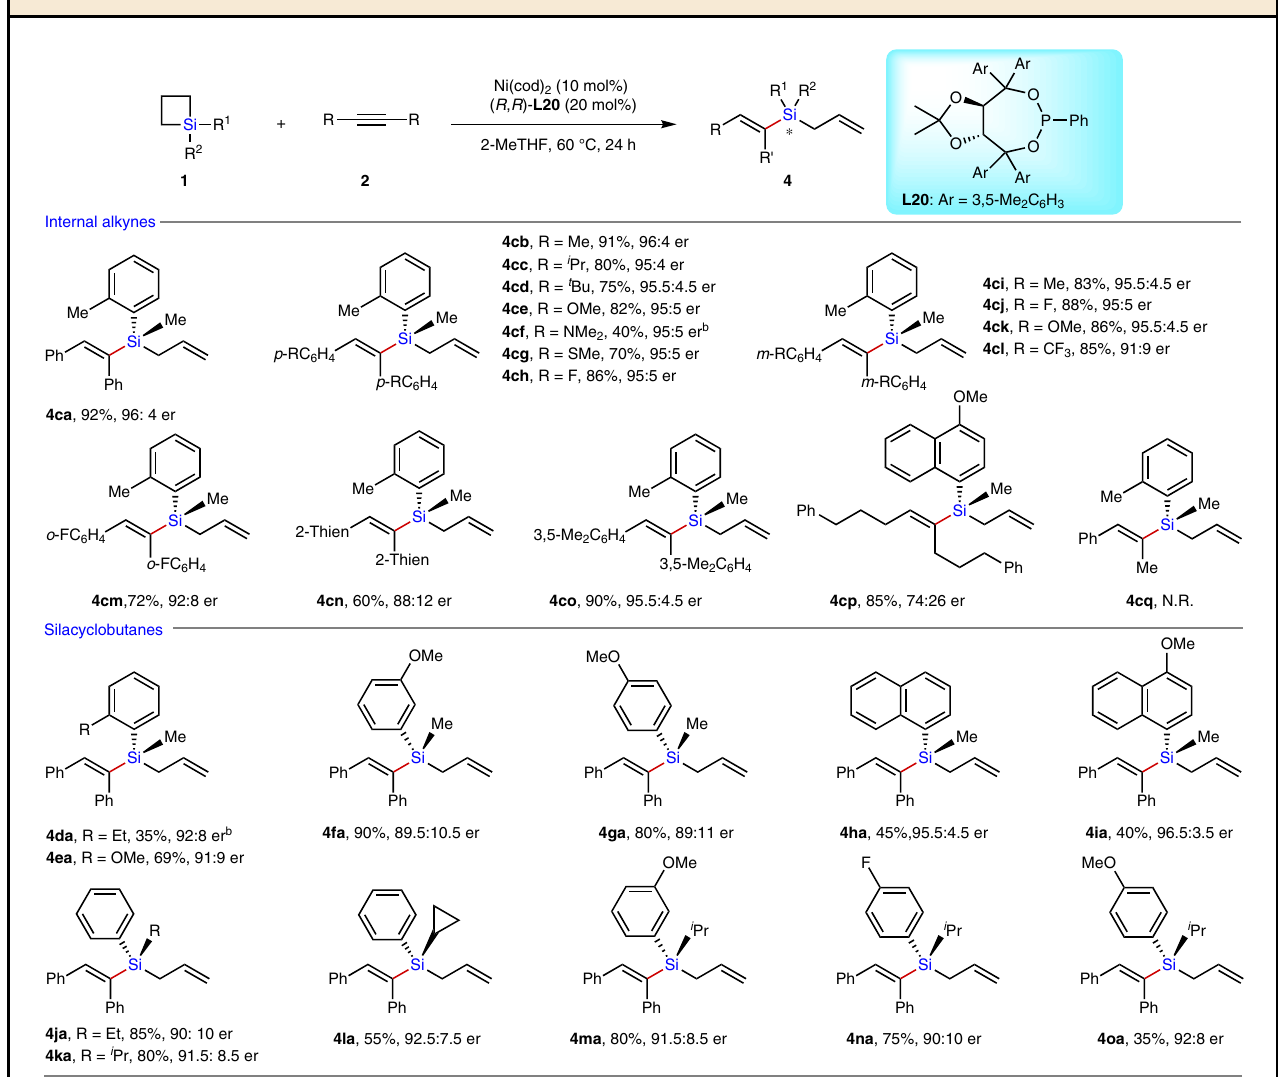
Table 4 Substrate scope for enantioselective synthesis of silicon-stereogenic allyl vinylsilanes 4 a